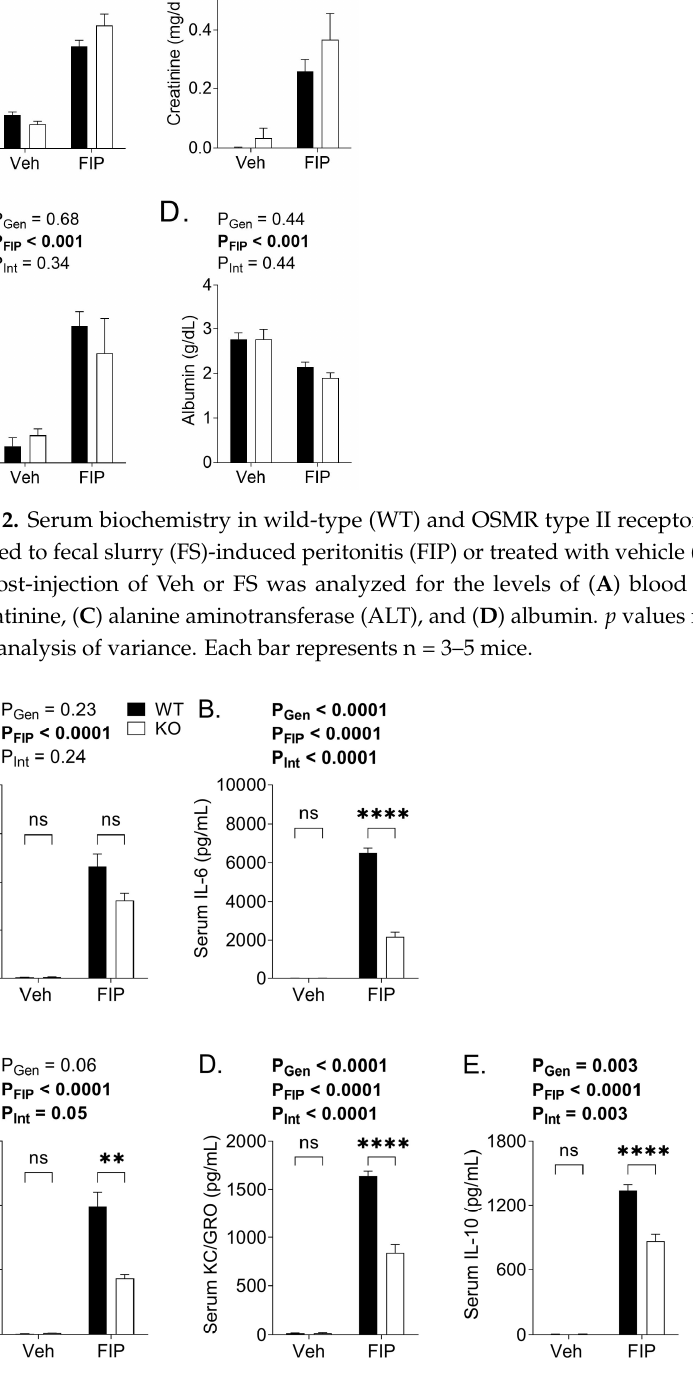
Table 1. Tissue cytokines/chemokine profiles.